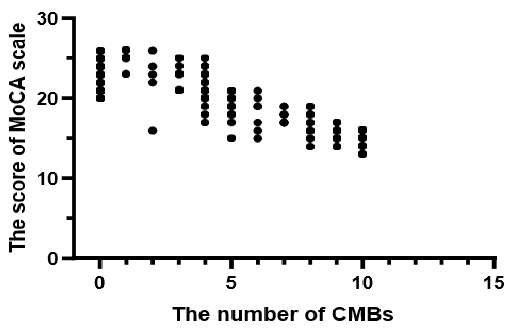
Figure 2. The scatter diagram of the number of CMBs and MoCA scores.